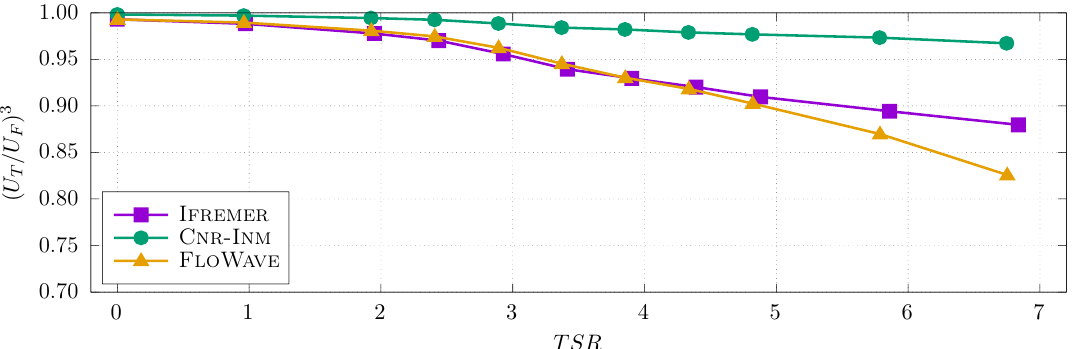
Figure 16. Blockage correction factor ( U T / U F ) 3 versus TSR to be applied to the power coefficient, according to the method presented by Bahaj et al. [11]. These coefficients are processed from case 4 (current-only at 1.0